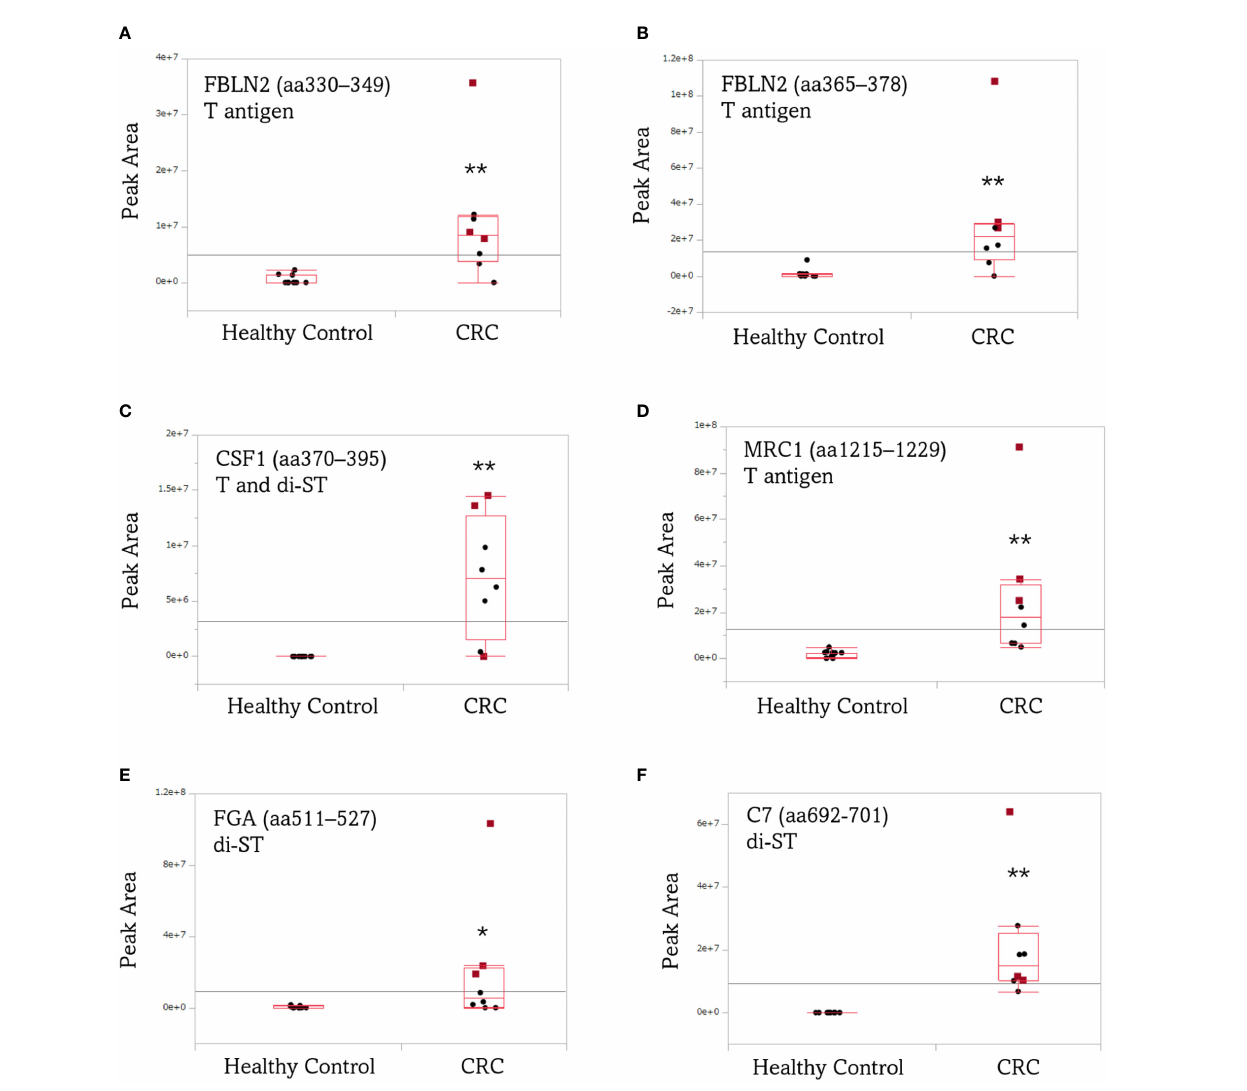
FIGURE 6 Box plots comparing the average peak area of aberrant O-glycoforms in the serum of patients with advanced CRC and healthy individuals. (A) FBLN2 (aa330 – 349)/T, (B) FBLN2 (aa365 – 378)/T, (C) CSF1 (aa370 – 395)/(T + di-ST), (D) MRC1 (aa1215 – 1229)/T, (E) FGA (aa511 – 527)/di-ST, (F) C7 (aa692-701)/ di-ST. Each dot represents the O-glycoform level of an individual specimen. The line inside each box indicates the median and the lower and upper hinges correspond to the fi rst and third quartiles. Wilcoxon matched-pairs signed rank test was performed using the peak area of the O-glycoform. Red squares: CEA/CA19-9 (+/+). **, p < 0.01; *, p < 0.05. CEA/CA19-9, carcinoembryonic antigen/carbohydrate antigen 19-9; FBLN2, fi bulin-2; CSF1, colony- stimulating factor 1; MRC1, mannose receptor 1; FGA, fi brinogen alpha chain; C7, complement component